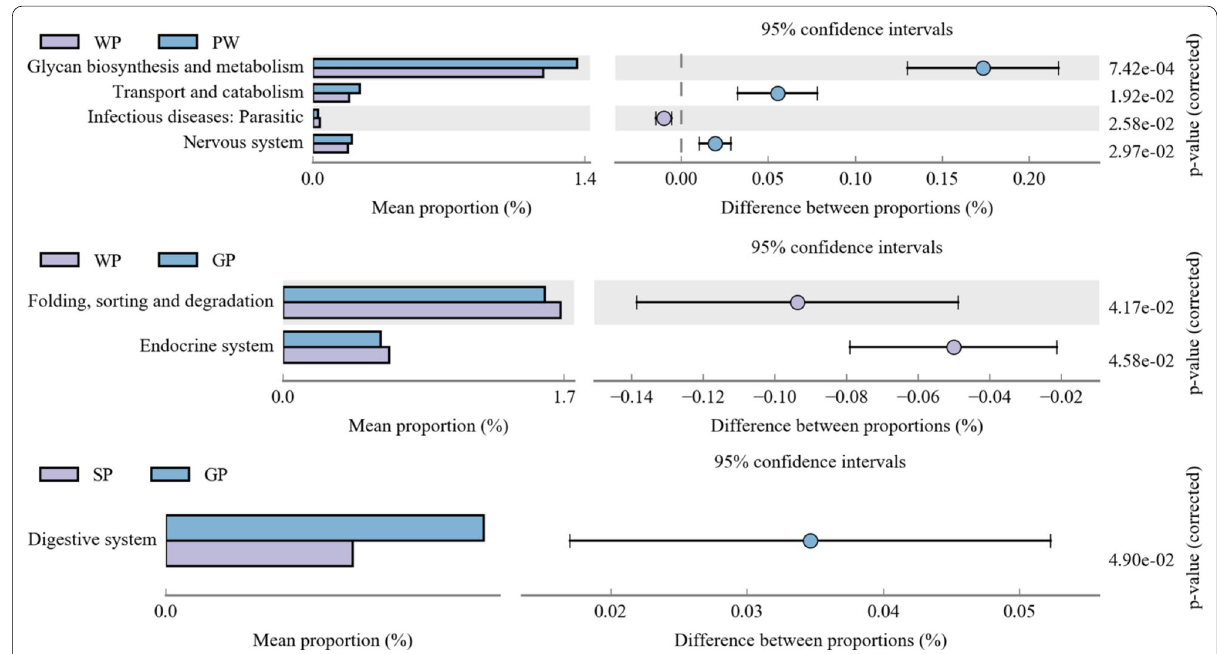
Fig. 3 Comparison of enriched KEGG metabolic pathways in fecal microbiota of pigs at different grow stages. The left figure in the picture shows the abundance ratio of different functions in two groups of samples, the middle shows the difference ratio of functional abundance in the 95% confidence interval, and the right value is the p ‐ value. KEGG, Kyoto Encyclopedia of Genes and Genomes